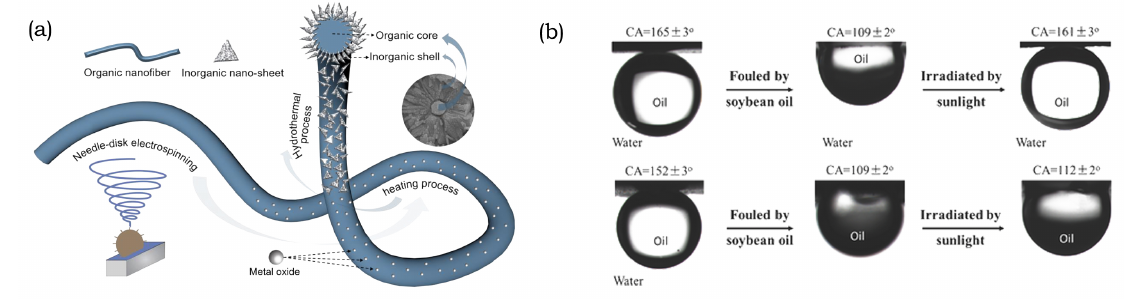
Figure 10. ( a ) Fabrication of an electrospun core-shell nanofiber. Reproduced with permission from [228], published by MDPI AG. License CC-BY. ( b ) Changes of the oil contact angle from before membrane testing, to after testing and after photocatalytic cleaning. From left to right, the changing OCA for GO/gCN(H)@TiO 2 and GO. Copyright (2018) Wiley. Adapted and used with permission from